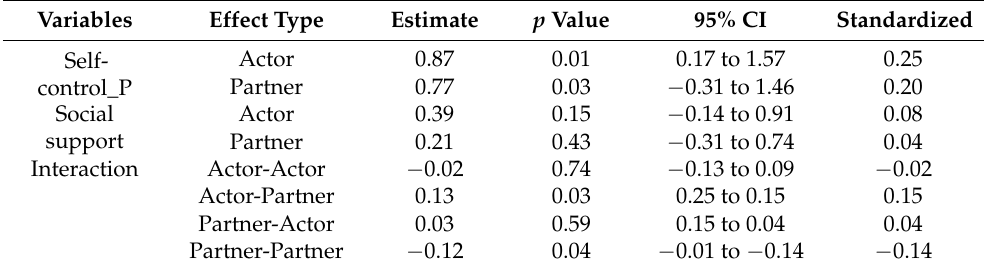
Table 4. Effects in the acquiring social support moderation